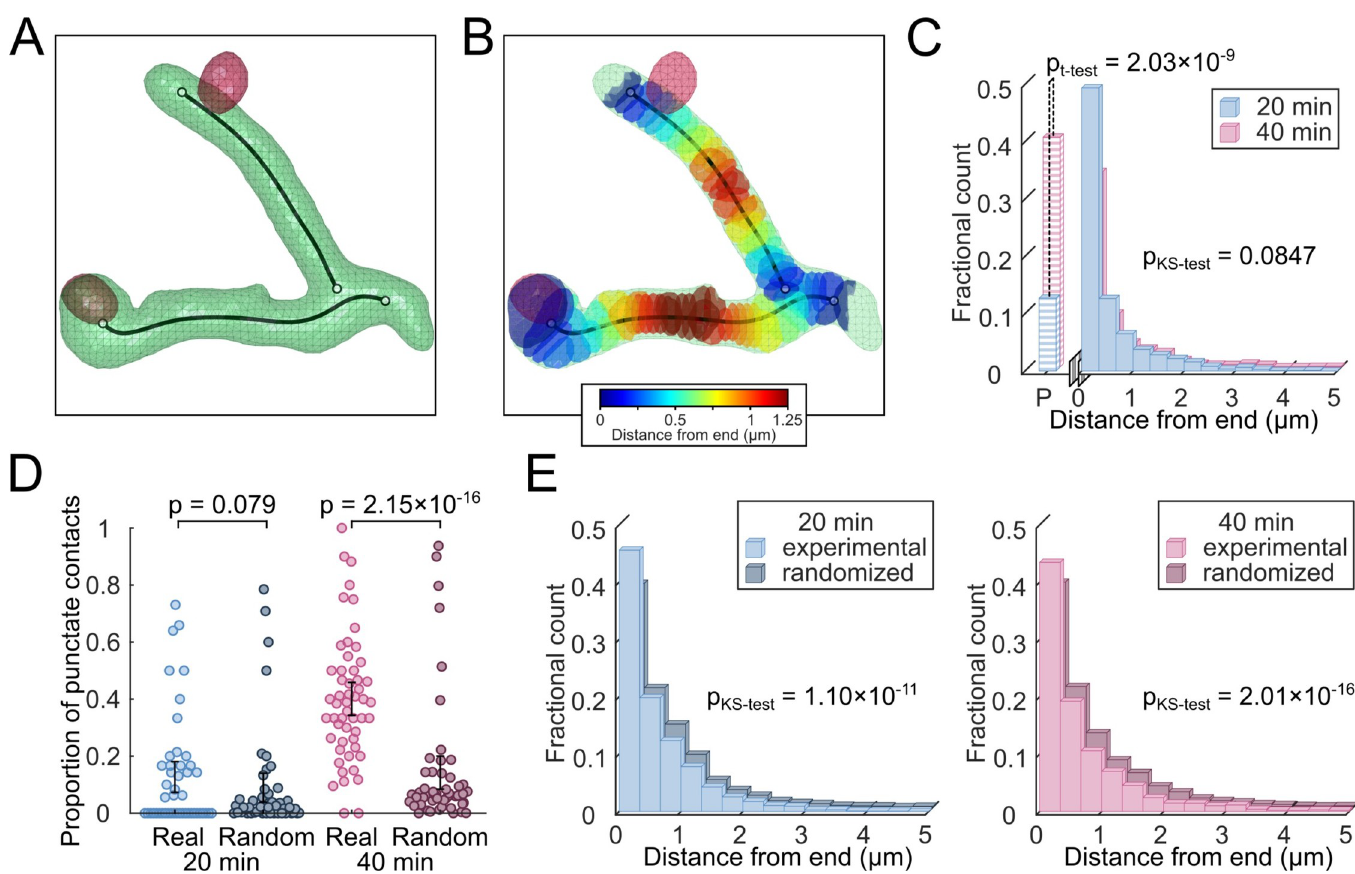
Fig 3. Autophagosomes preferentially localize to Bcl10-filament ends and, at later timepoints, to Bcl10 puncta. (A) Representative segmented Bcl10 filaments (green) and autophagosomes (red) after post-processing, overlaid with the pruned medial-axis skeleton of Bcl10 (black). Filament skeletons were fragmented to minimize the bending energy at junctions. (B) Using the skeleton of the representative Bcl10 filament, the filament volume was segmented into sections based on the nearest distance from skeleton ends. (C) Distribution of autophagosome-Bcl10 contacts by distance from endpoint (filamentous Bcl10) or punctate Bcl10 (“P”). (D) Scatter-bar plot of the proportion of Bcl10 puncta per cell in contact with an autophagosome in experimental and randomized data (i.e., puncta only). (E) Rescaled distance-from-endpoint distributions from (C) of only autophagosome-filamentous Bcl10 colocalizations in experimental and randomized data (i.e., puncta removed). p -values in C and E were calculated using two-sample KS tests and p -values in D were calculated using paired two-sample t -tests. p -values less than 0.05 were considered significant.